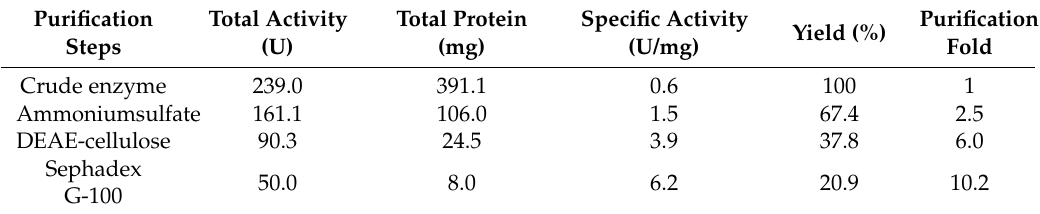
Table 1. Purification steps of CHI2 chitinase.